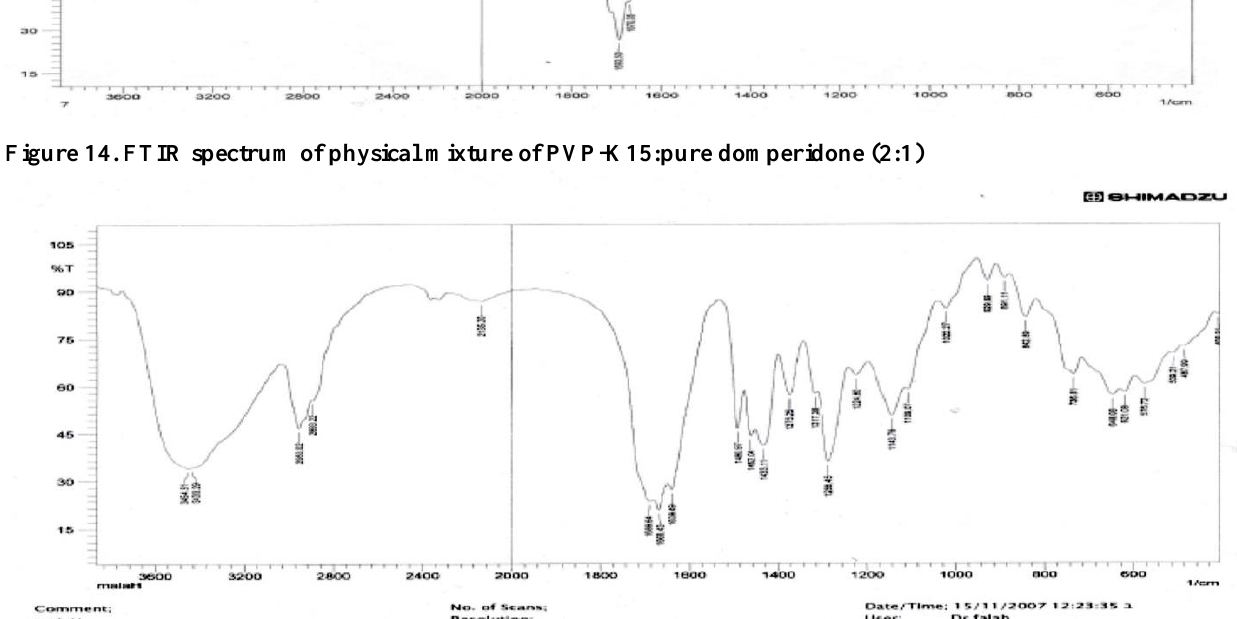
Figure 14. FTIR spectrum of physical mixture of PVP-K15:pure domperidone (2:1)